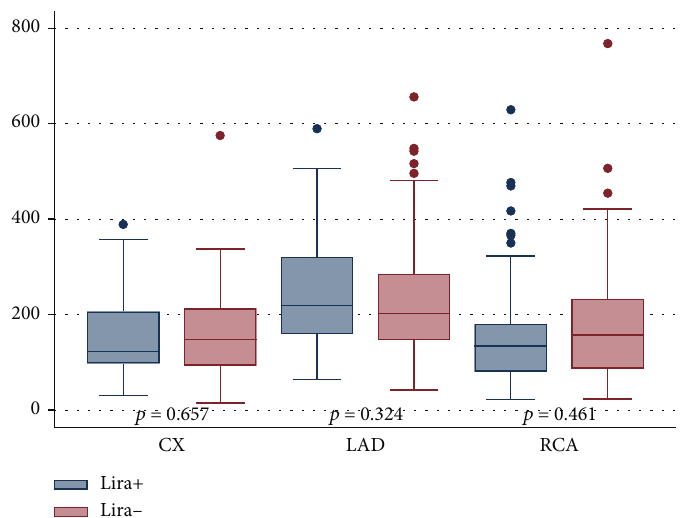
Figure 2: Plaque burden in the coronary arteries strati fi ed by liraglutide treatment. Abbreviations: CX: left circum fl ex artery; LAD: left anterior descending artery; RCA: right coronary artery; p values were calculated using two-sample Wilcoxon ’ s rank-sum (Mann – Whitney) test. Number of included segments: 182 CX, 188 LAD, and 184